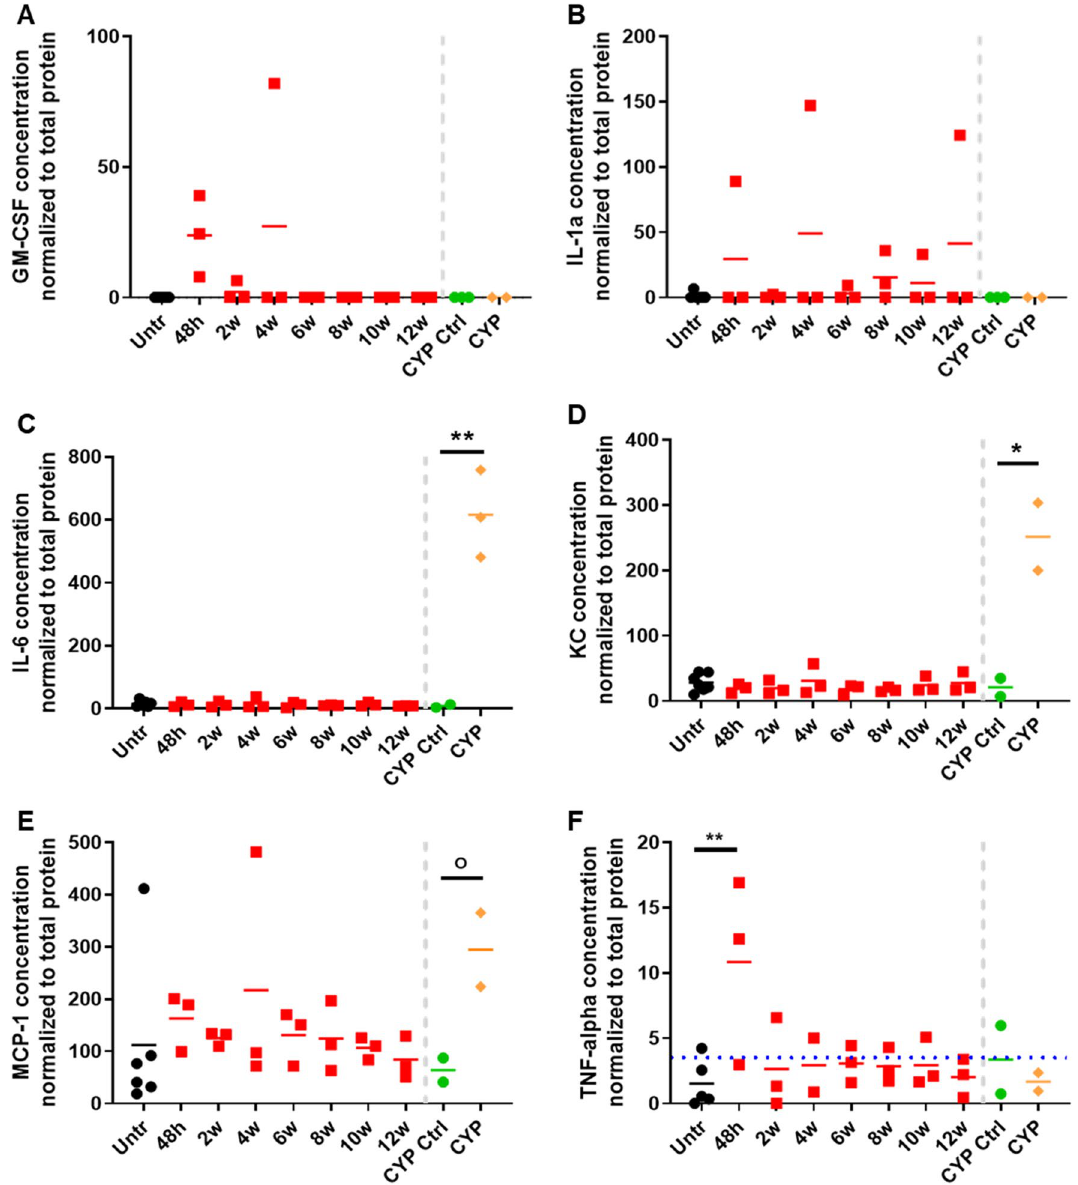
Figure 5. Levels of inflammatory cytokines are unaltered during the acute phase of RC. Cytokine levels were measured in whole bladder lysates from untreated (n = 3) and irradiated (n = 3/time point) bladders. Cyclophosphamide (n = 3) treated bladders and littermate controls (n = 3; CYP ctrl) were included as positive control for inflammation. GM-CSF granulocyte macrophage colony stimulating factor, IL interleukin, KC keratinocyte-derived cytokine, MCP-1 monocyte chemoattractant protein-1, TNF-alpha tumor necrosis factor- alpha; Blue dotted line: lowest range of assay